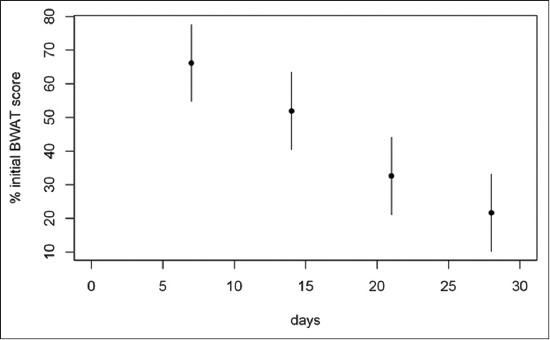
Mean percentage of initial Bates-Jensen Wound Assessment Tool score (BWAT) during the 1st month of treatment. The mean percentage of BWAT score at day 7 was 66.15% (95% confidence interval [CI]: 54.7-77.6), at day 14 was 51.96% (95% CI: 40.5-63.4), at day 21 was 32.63% (95% CI: 21.1-44.1) and at day 28 was 21.70% (95% CI: 10.2-33.2) of the admission score.